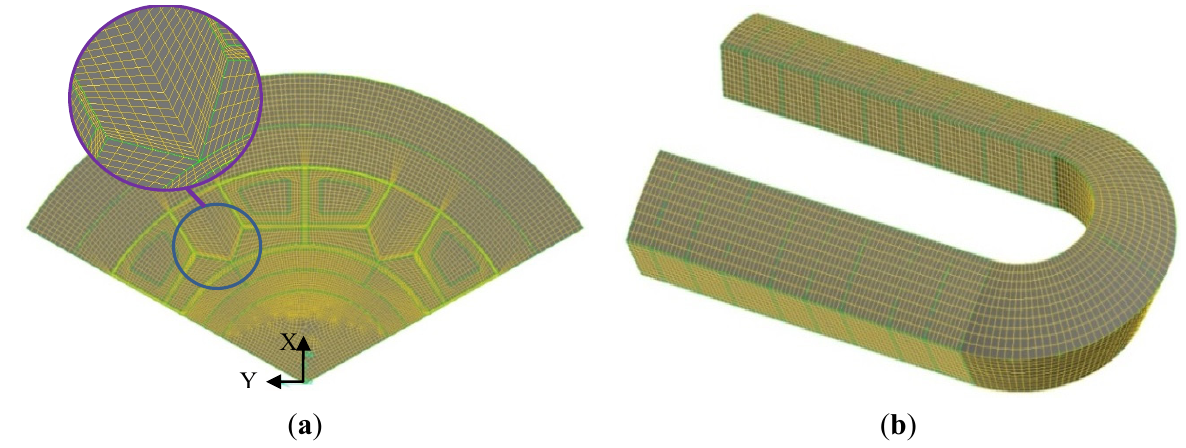
Figure 5. Meshing of the physical model: ( a ) local view; and ( b ) stator